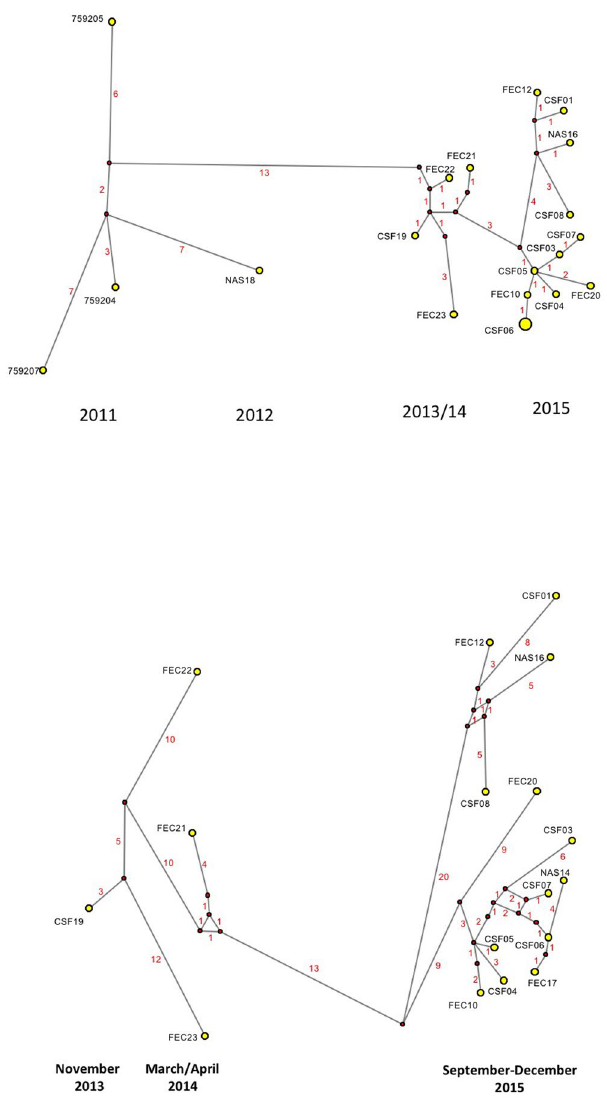
Figure 4. Median-joining phylogenetic network of the analysed HPeV3 sequences. The networks shown include all of the most parsimonious trees linking the sequences. Each unique sequence is represented by a circle showing the identity and frequency in the dataset. Branch length is proportional to the number of nucleotide differences and the number of nucleotide differences between nodes are shown in red. (A) Network based on the capsid encoding region from nucleotide 701–3013 and including all 18 Australian sequences as well as the 3 selected Yamagata 2011 lineage virus sequences as indicated in Fig. 1. The larger circle labeled CSF06 also includes samples NAS14 and FEC17 as the sequences of these 3 samples/cases were identical for the capsid encoding region. Year of samples obtained shown at the bottom. (B) Network analysis based on the full open reading frame from nucleotide 701–7231 and only including the 17 Australian virus sequences from 2013–2015, i.e. the novel Australian recombinant HPeV3. Month and year of samples obtained shown at the bottom. For more details on samples see Table